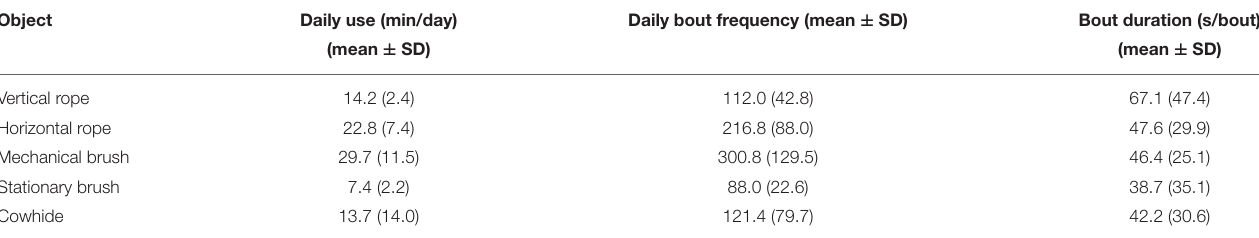
TABLE 5 | Daily use (mean ± SD), daily bout frequency (mean ± SD), and duration (mean ± SD) for using five enrichment objects observed in 25 calves kept in groups of five for five replicates recorded continuously 12h per day for 1